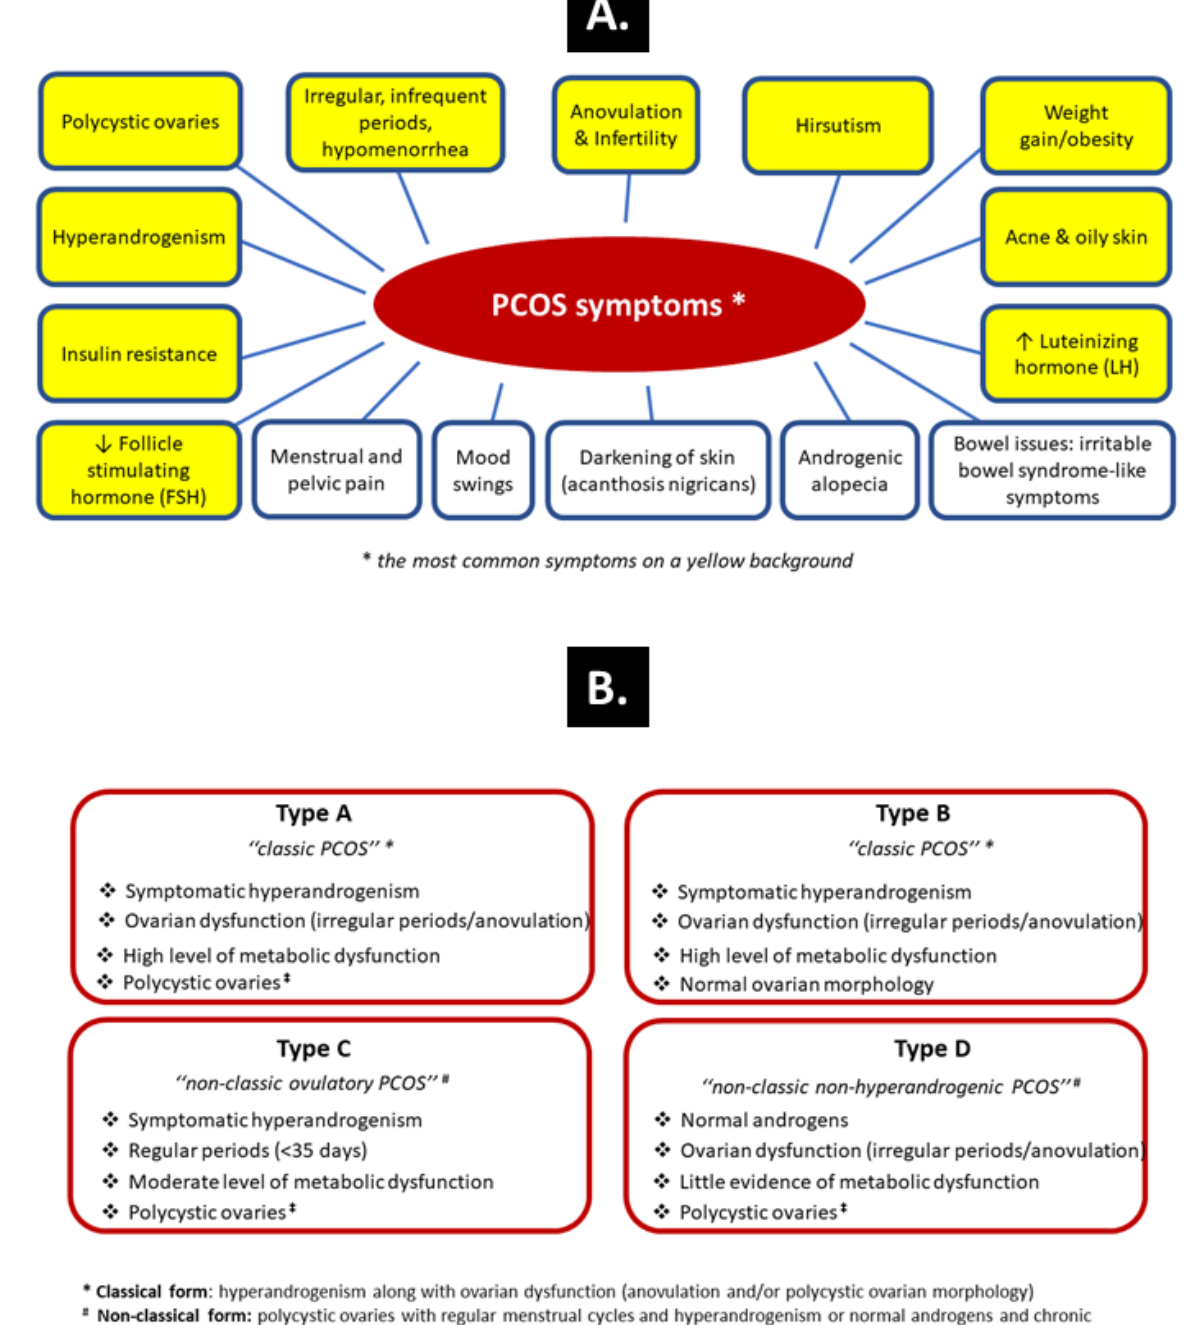
Figure 1. Symptoms of PCOS ( A ) and the simple clinical classification taking into account the phe- notypes of PCOS ( B ) [6]. phenotypes of PCOS ( B )